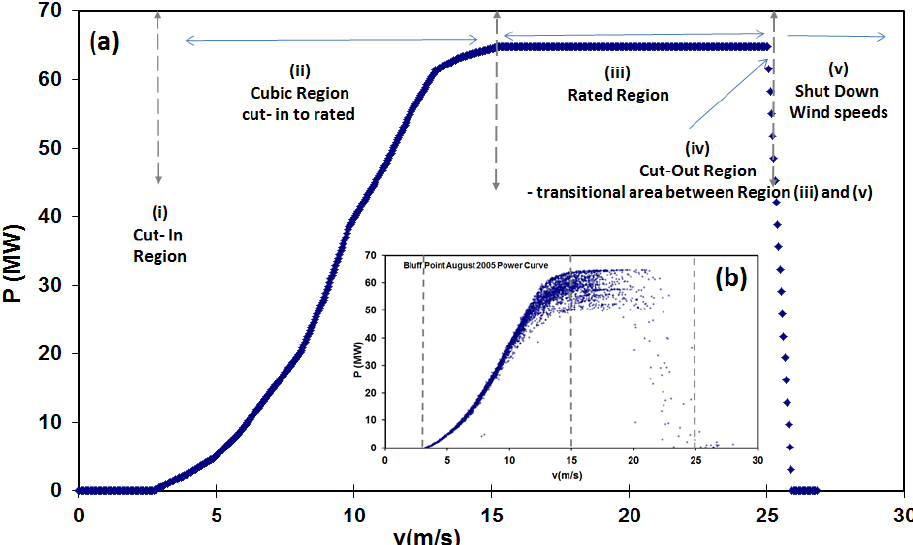
Figure 2. ( a ) The manufacturers power curve for the turbines on site at Bluff Point. Five regions of interest are identified and labelled (a detailed explanation of each region can be found in Table 1); ( b ) The actual power curve for Bluff Point for August 2005. Table 1. The different wind speed ranges of the power curve that relate to the regions in Figure 1.